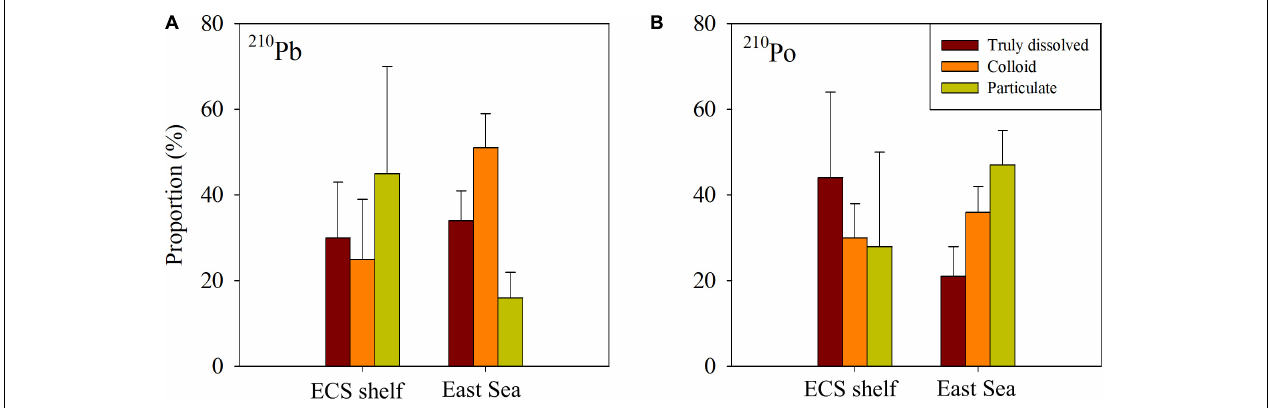
FIGURE 3 | Proportions of 210 Pb (A) and 210 Po (B) in truly dissolved ( < 10 kDa), colloidal (10 kDa–0.2 µ m), and particulate ( > 0.2 µ m) phases in the East China Sea (ECS) shelf water and the East